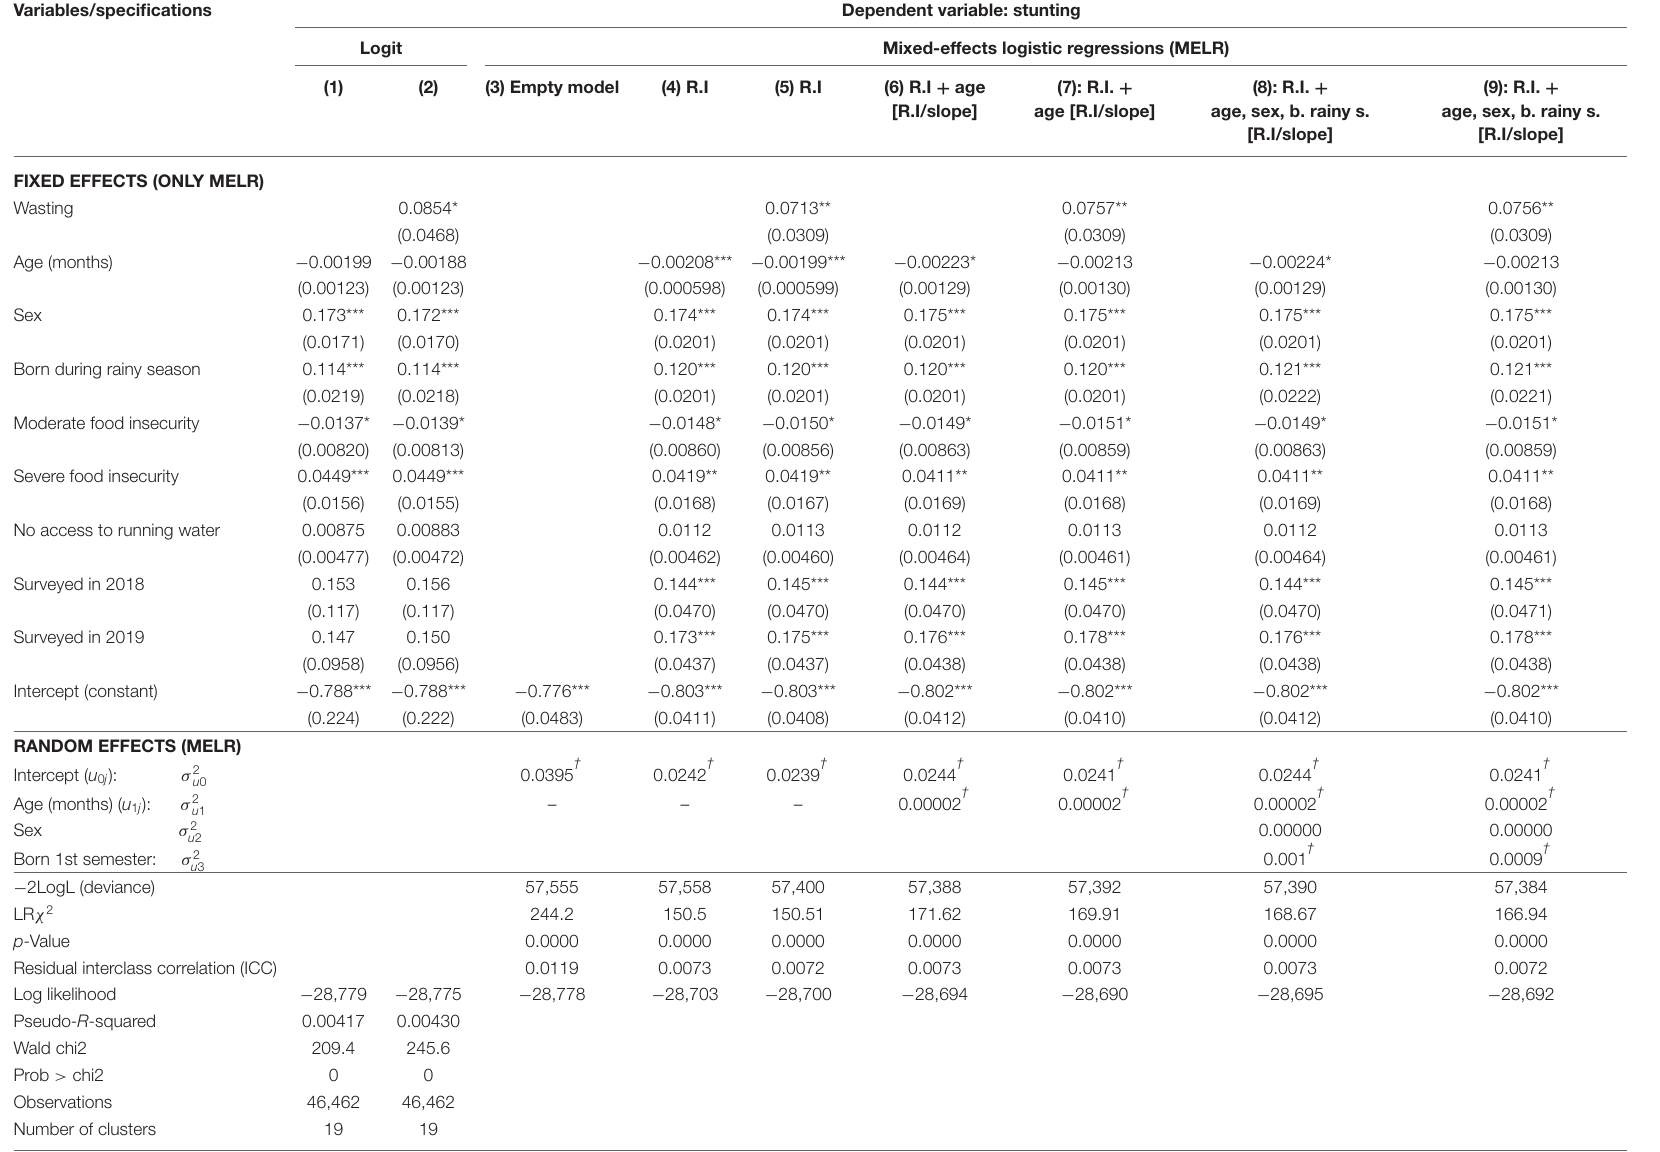
TABLE 5 | Logit and multilevel logistic regression specifications for the probability of being